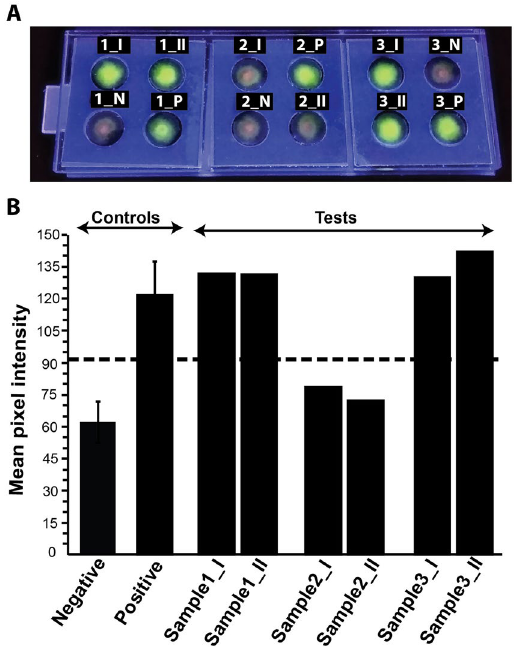
Figure 7. TB testing for clinical samples in FLIPP-NAAT. ( A ) Three clinical samples were tested per device with a negative and positive control in each module. Each sample was run in duplicates. Numbers on top of each zone represent the sample number and suffix ‘I’ and ‘II’ represent the duplicates. N – negative control and P – positive control. ( B ) Mean pixel intensity of green color from all the six blind clinical samples, negative and positive controls. The dashed line represents the threshold value of ( µ N + 3 σ N ). Samples with intensity below the threshold were considered as TB negative while samples with green color intensity above the threshold were considered as TB